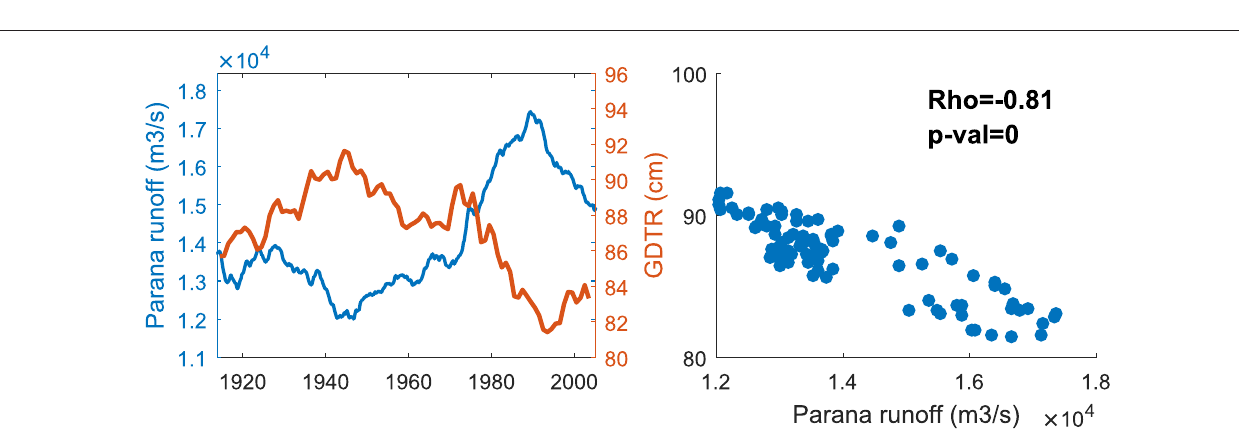
FIGURE 9 | Comparison of the Paraná runoff (19-y running average) and the GDTR of Buenos